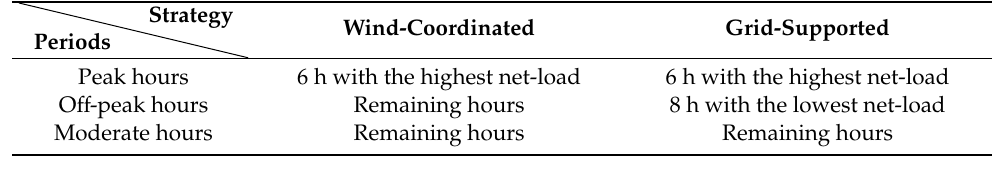
Table 3. Di ff erent periods of operational strategies.